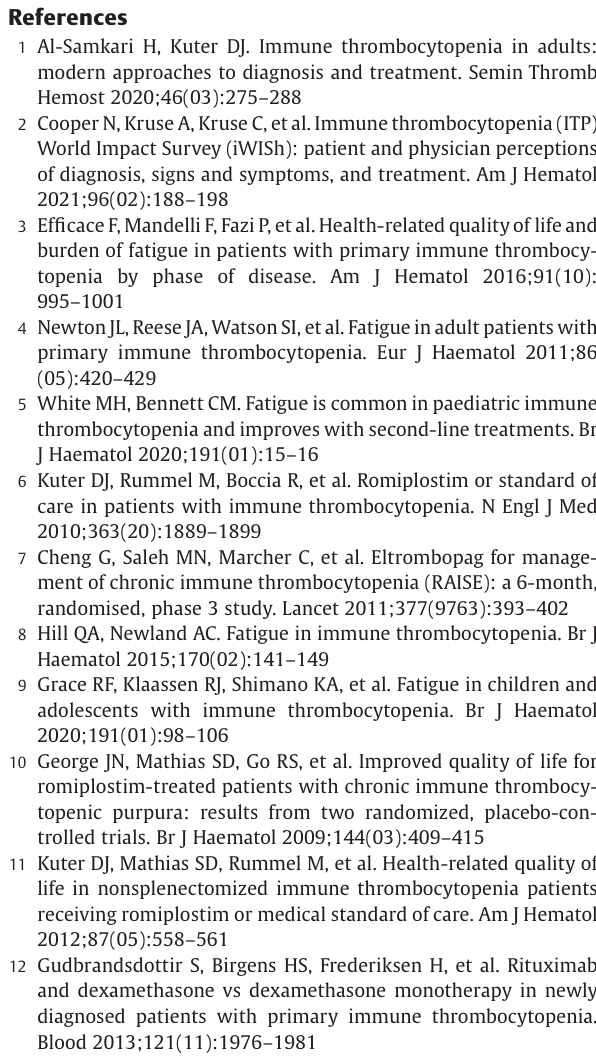
(cid:129) ► Supplementary Table S2 . Immune thrombocytopenia Bleeding Assessment Tool (ITP-BAT) scores per domain and item in all patients (cid:129) ► Supplementary Table S3 . Multivariable models assessing the relative contribution of the questions within the respective subscales of the Functional Assessment of Cancer Therapy-General (FACT-G) (cid:129) ► Supplementary Table S4 . Full model with all signi fi - cant predictors ( p <